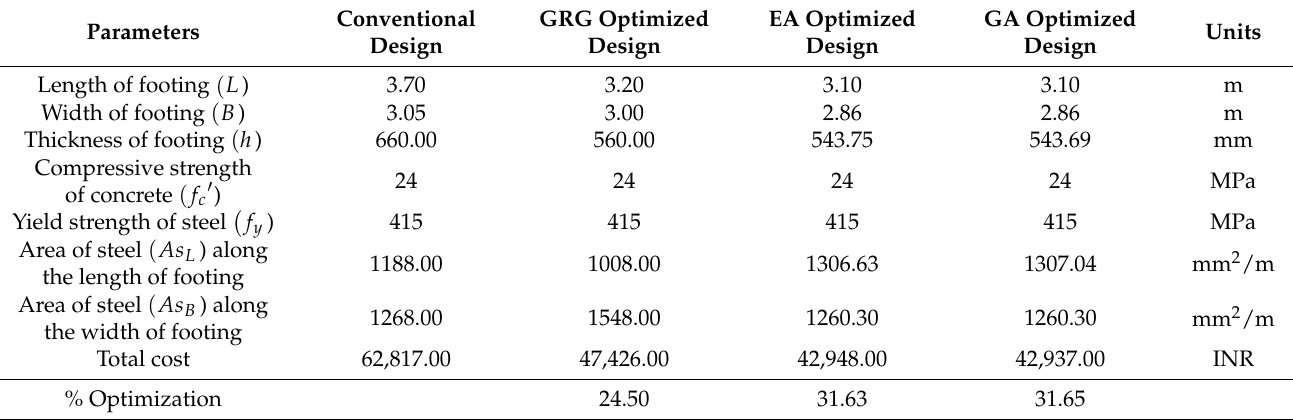
Table 4. Optimum values obtained for example 1.